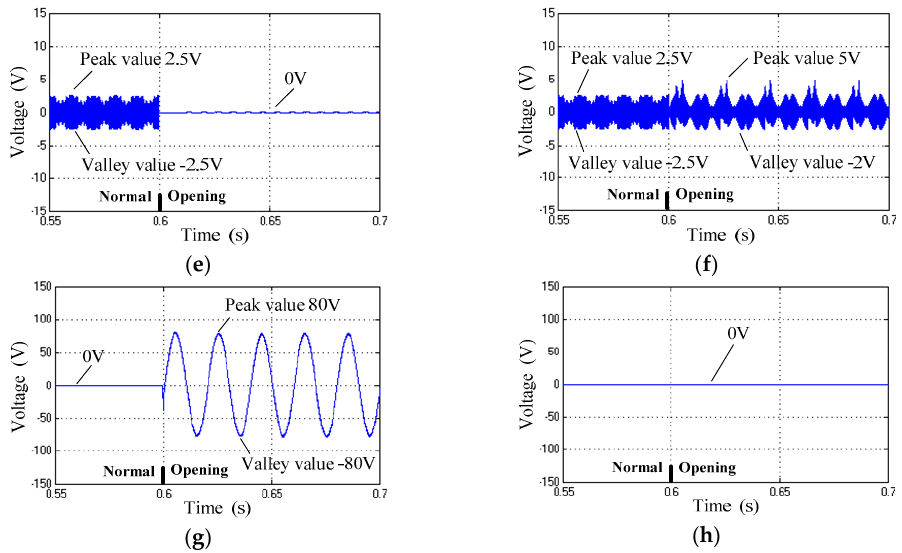
Figure 10. Decoupling plane voltages by low-pass filtering in simulations 1 and 2. ( a ) d-q axis voltages in simulation 1; ( b ) d-q axis voltages in simulation 2; ( c ) z 1 axis voltage in simulation 1; ( d ) z 1 axis voltage in simulation 2; ( e ) z 2 axis voltage in simulation 1; ( f ) z 2 axis voltage in simulation 2; ( g ) z 3 axis voltage in simulation 1; ( h ) z 3 axis voltage in simulation 2.